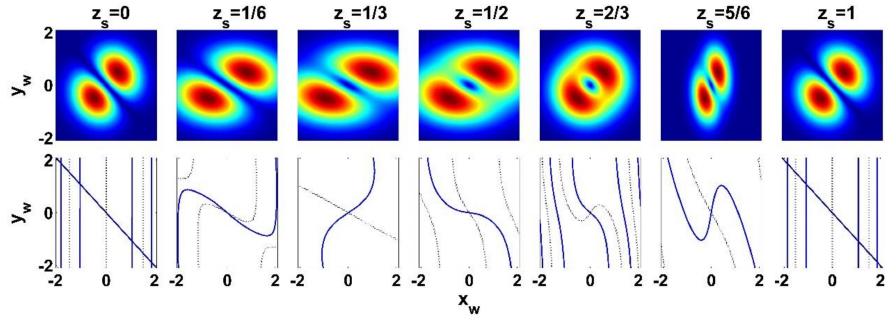
Figure 4. Same as Figure 3 but for z p = z R , β x = β y = 1/3, R 0x = 3 z R /4, R 0y = ∞ .